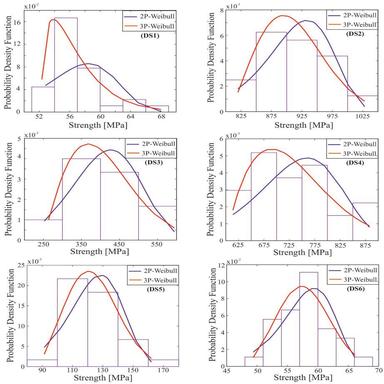
Probability density function of experimental strength datasets and their fits with 2P-and 3P-Weibull distribution functions.